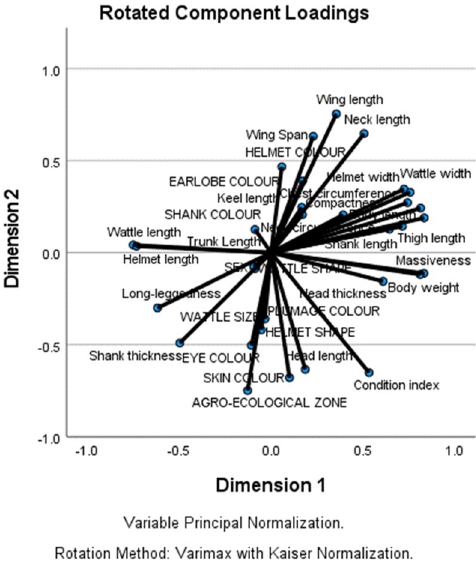
Fig 4. Individual biometric traits, morphological indices and qualitative physical traits loadings on the principal components.